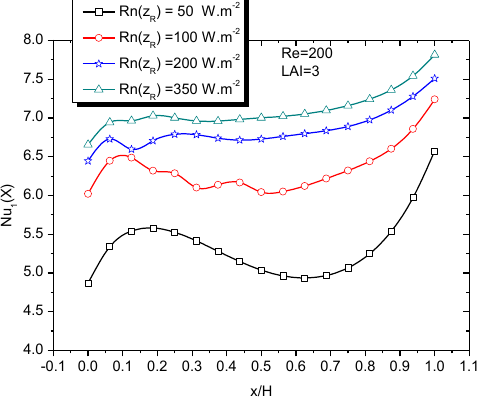
Figure 6 . Effect of solar flux density on the variation of the local Nusselt number for